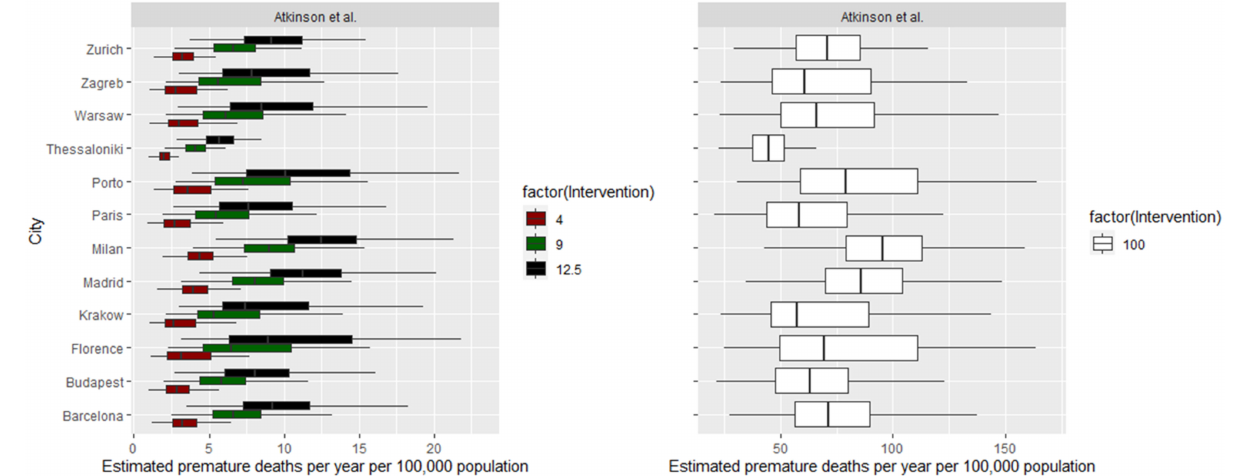
Figure 6. Estimated premature mortality/year per 100,000 population due to exposure to NO 2 concentrations (baseline scenario) in the study cities, using risk estimate by Atkinson et al. [69], and applying three different intervention scenarios (4, 9 and 22% reduction in concentrations). It is shown in comparison with the baseline/control scenario (100% reduction). The line within the box plots shows the median concentrations, while the box bottom and top represent the 25th and 75th percentiles, respectively. The whiskers represent the lower (2.5th percentile) and the upper (97.5th percentile) bounds. Note on the different x